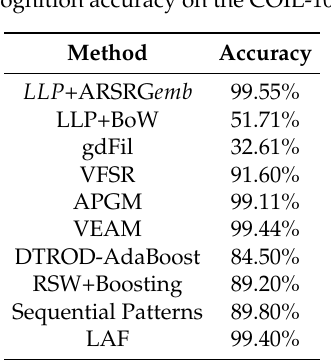
Table 8. Recognition accuracy on the COIL-100